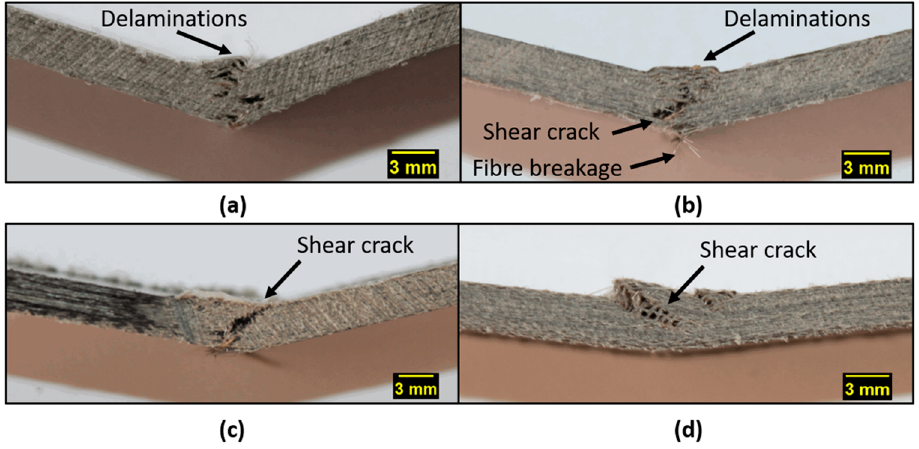
Figure 5. Optical through-thickness micrographs corresponding to the bending point: ( a ) Plain_TL, ( b ) Plain_P40, ( c ) Twill_TL, and ( d ) Twill_P40. Table 2. Impact parameters at penetration. Standard deviations are reported in brackets.